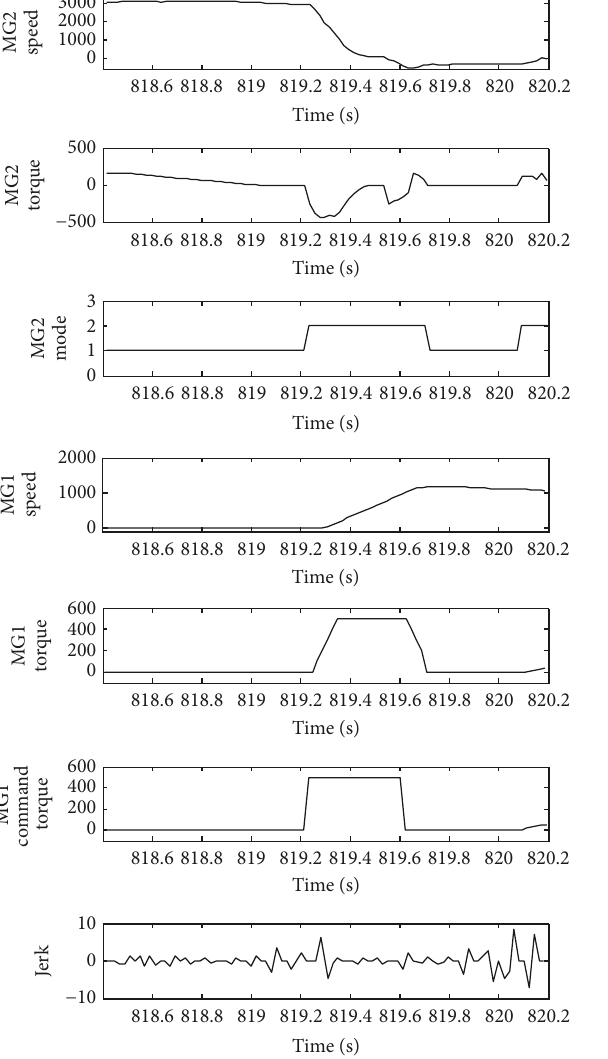
Figure 22: The variation curves of speed and torque of two motors.